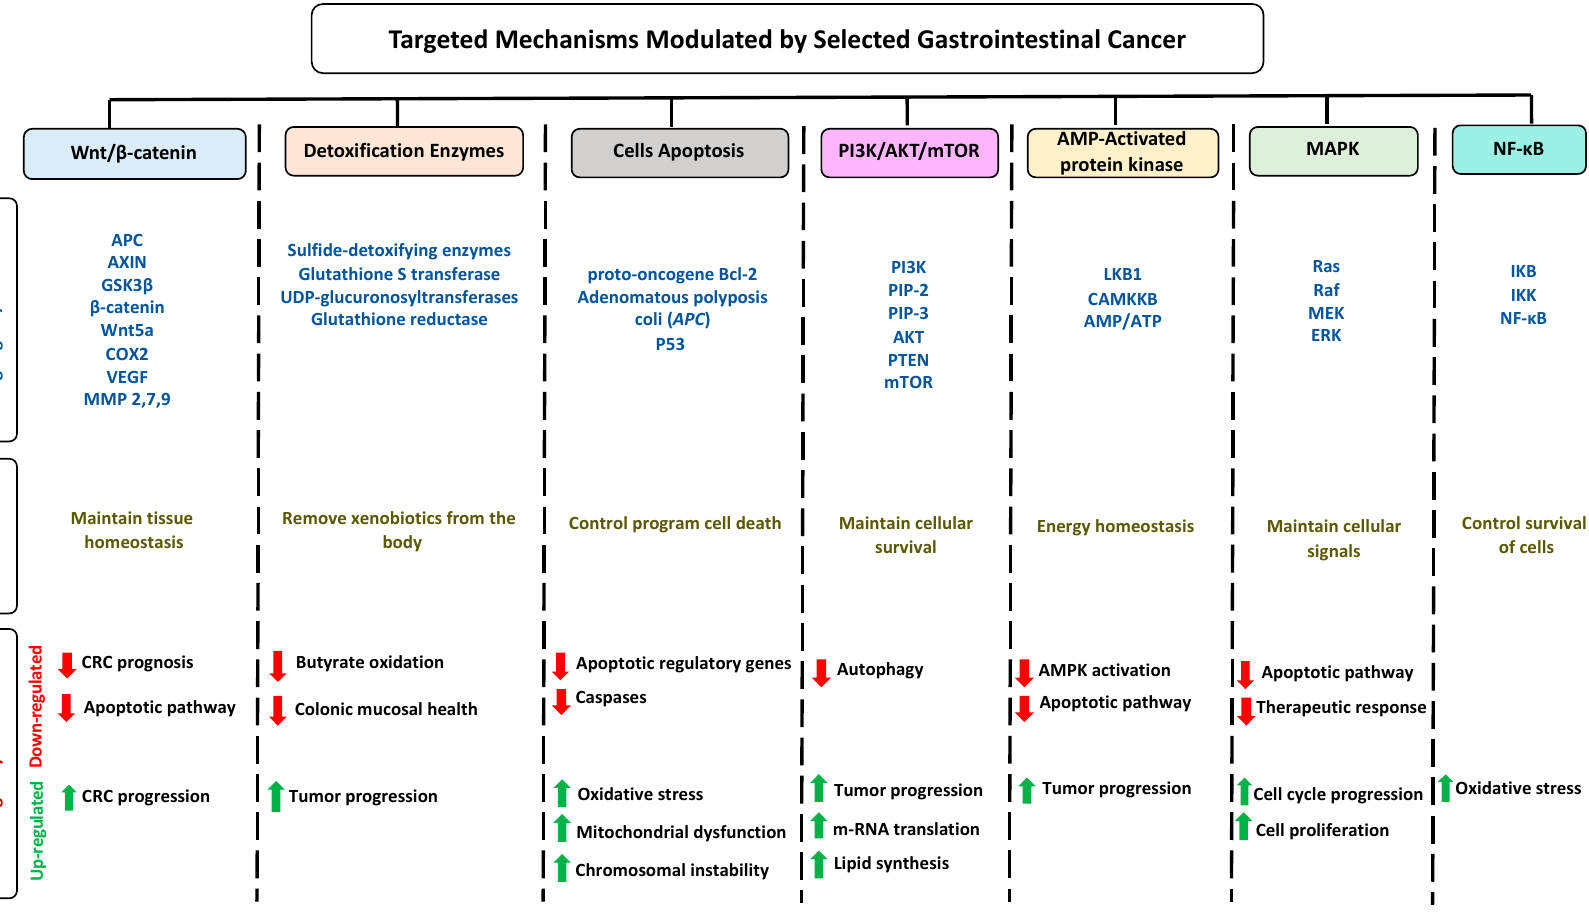
Figure 1. Schematic illustration of seven selected mechanisms modulated by GI cancer. The figure is divided into seven columns and three rows. The column headings represent the pathways while the row headings represent target genes/proteins for each pathway (blue), the overview physiological effect of these genes on pathways (dark yellow), and changes occurring on these pathways modulated by GI cancer.